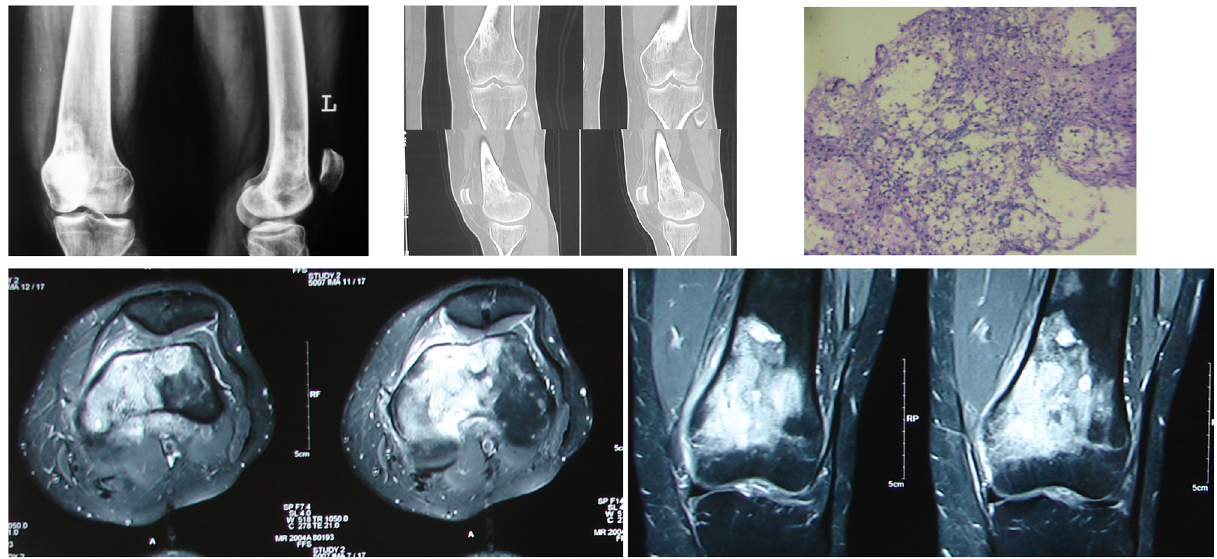
Figure 3. A 24-year-old female referred to our center with a history of mass progressively increasing in size over the past 3 months with a history of weight loss and progressive pain. X-ray shows a dense sclerotic lesion with enhancing marrow oedema on the MRI. The fi nal diagnosis was based upon